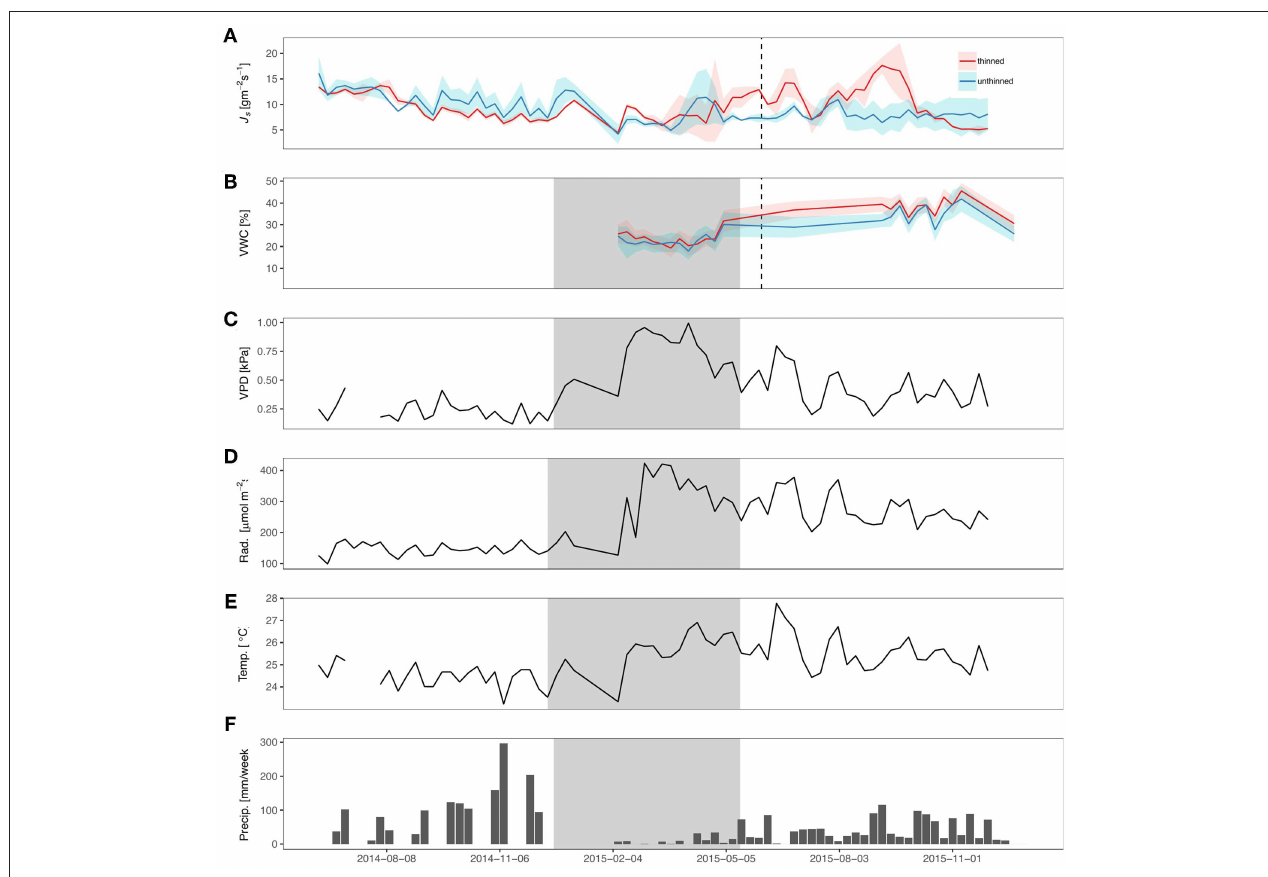
FIGURE 1 | Sap flux density and meteorological variables during sampling period. (A) Mean sap flux density ( J s ; gm − 2 s − 1 ), (B) mean volumetric water content (VWC; %) for top 30cm, (C) Vapor pressure deficit (VPD; kPa), (D) net radiation (Rad; W m − 2 ), (E) temperature (Temp.; ◦ C), and (F) precipitation (precip.; mm week − 1 ) from June 2014 through June 2016. Gray shading represents dry season and dashed line represents the timing of the thinning.